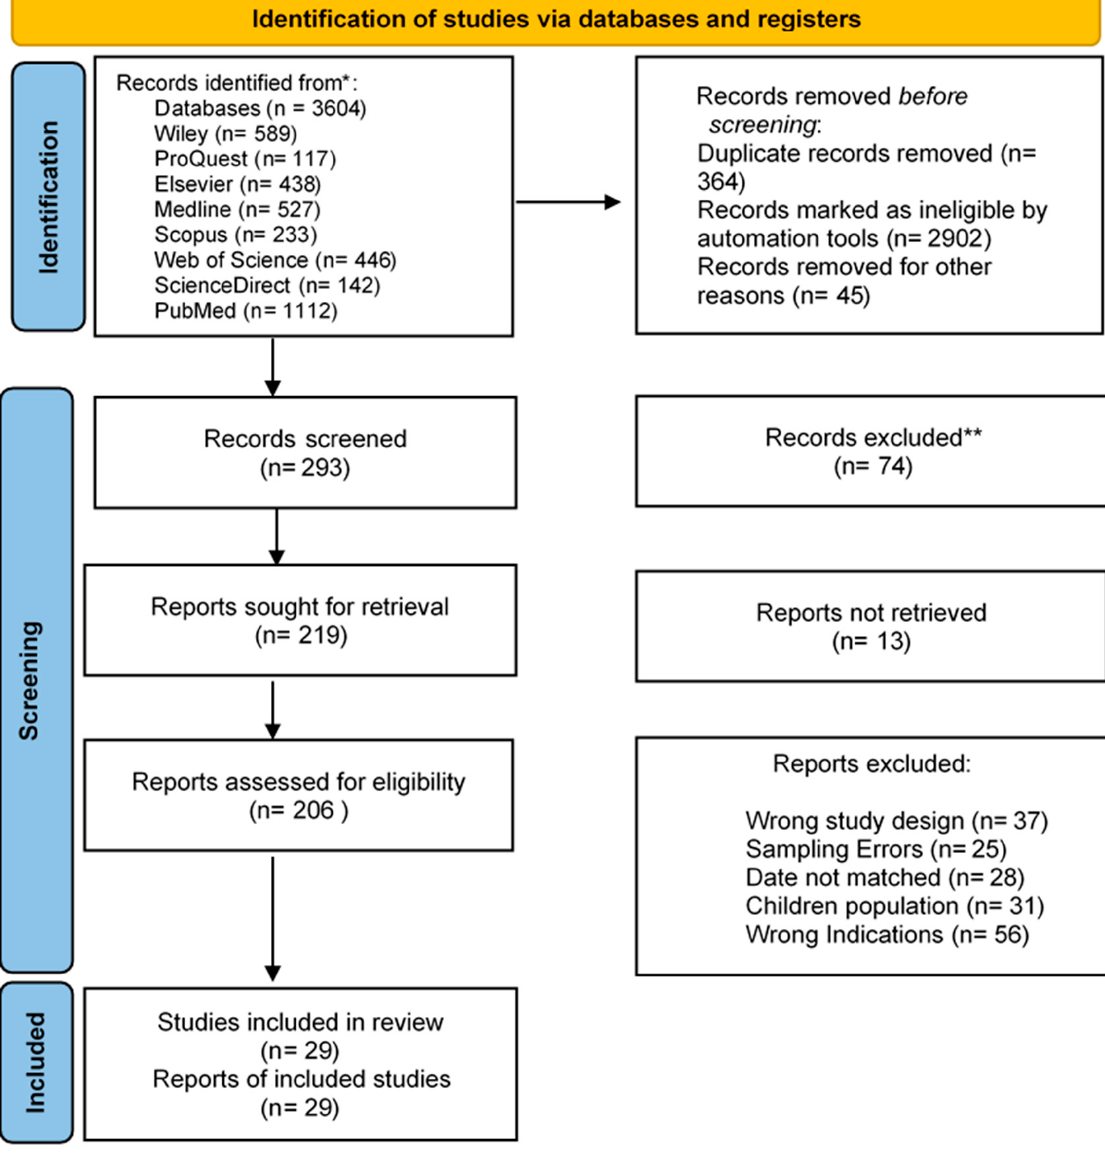
Figure 1. Flow diagram illustrating different stages of sampling (Page et al. 2021). * There could be more relevant databases on the topic. ** Excluded records in all stages were checked triple times to ensure justifiability.